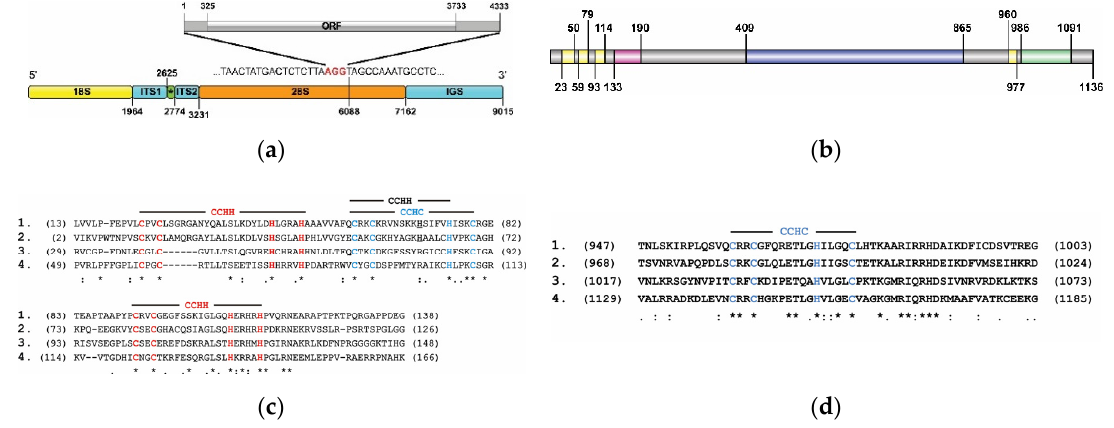
Figure 1. Structural organization of the R2 retrotransposon of Blattella germanica . ( a ) Schematic representation of the structure of the cluster of ribosomal RNA genes with the integration site of the R2 retrotransposon indicated. Corresponding structural elements are highlighted in blocks of different colors. The asterisk denotes the 5.8S RNA gene. The numbers indicate the beginning and end of the corresponding structural units. Three nucleotides were absent in the 28S sequence, suggesting that they were deleted during the integration process. These nucleotides are indicated in red. Gray blocks show the open reading frame (ORF) and 5 ′ -, 3 ′ -untranslated regions of the R2 retrotransposon; ( b ) Protein domain organization corresponding to the ORF of the R2 retrotransposon of B. germanica . The yellow blocks are zinc-finger domains, the crimson block is the c-myb domain, the blue block is the reverse transcriptase domain, and the green block is the endonuclease-like domain. The numbers indicate the positions of the beginning and the end of the corresponding domain. The alignment of the ( c ) N-terminal and ( d ) C-terminal zinc-finger motifs: 1 — B. germanica , 2 — R. maderae , 3 — Reticulitermes lucifugus , 4 — Kalotermes flavicollis . The CCHH type of the zinc-finger motifs is shown in red font and the CCHC type in blue. The CCHH type of the zinc-finger motif is indicated in black (explained in the text). The proteins encoded by R2 retrotransposons recognize and cut evolutionarily conserved sequences, providing the integration of TEs into a strictly defined rDNA region. The site for the cutting the rDNA sequence of B. germanica during the integration of the R2 retrotransposon is located between nucleotides 2856 and 2857 of the 28S RNA gene (Figure